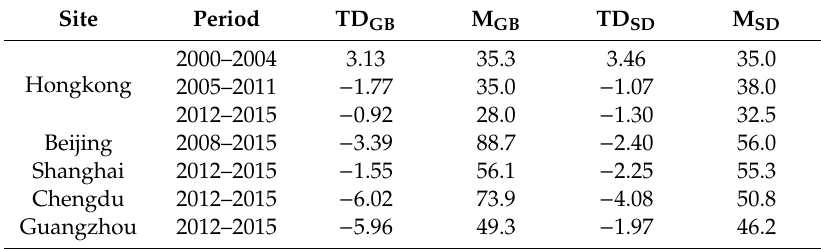
Table 1. Trend (TD) and mean value (M) of satellite-derived yearly PM 2.5 and in situ measurements in Hongkong, Beijing, Shanghai, Chengdu and Guangzhou, for di ff erent periods. In situ PM 2.5 in Hongkong is averaged over 12 sites; that in the four other cities were measured at U.S. embassies. M GB and M SD are “ground-based” and “satellite-derived” in units of µ g m − 3 . Site Period TD GB M GB TD SD M SD 2000–2004 3.13 35.3 3.46 35.0 Hongkong 2005–2011 − 1.77 35.0 − 1.07 38.0 2012–2015 − 0.92 28.0 − 1.30 32.5 Beijing − 3.39 88.7 − 2.40 56.0 Shanghai − 1.55 Chengdu